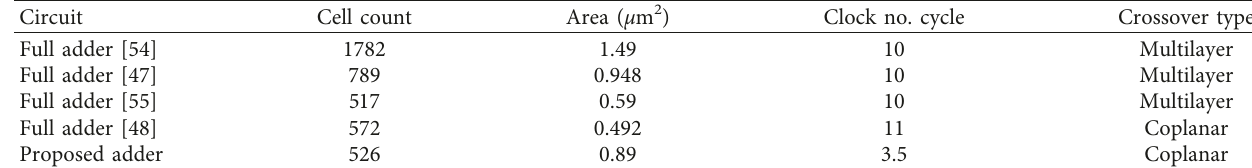
Table 2: Comparison of the proposed 8-bit adder with the previous works.